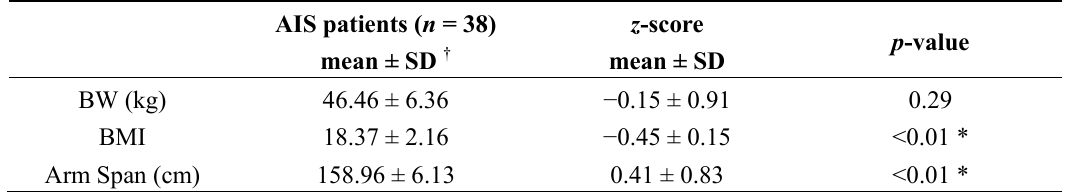
Table 2. Clinical evaluation of AIS patients. The z -score of body weight (BW), body mass index (BMI) and arm span of AIS patients were compared against the normal population by one sample Student’s t -test using zero as the reference value. All data were expressed as the mean ± SD, * p < 0.01. † The mean values were not adjusted for